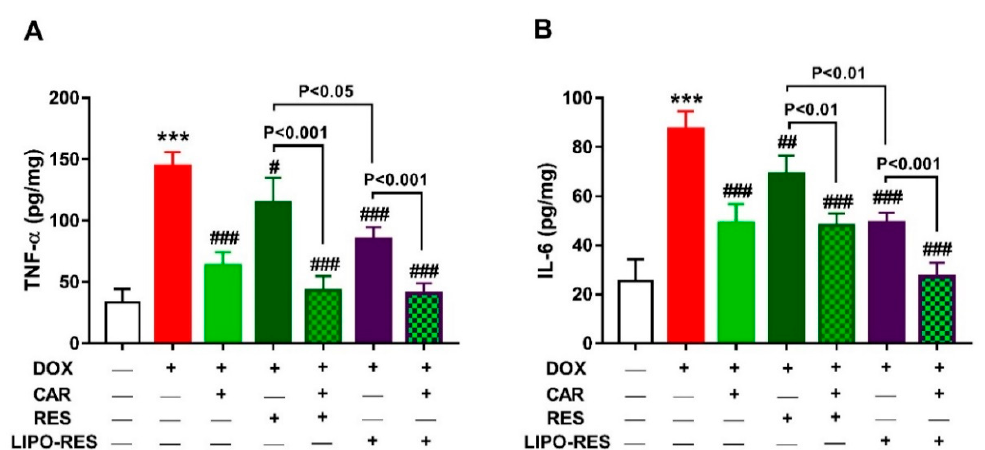
Figure 5. CAR and/or RES and LIPO-RES decrease cardiac TNF- α ( A ) and IL-6 ( B ) in DOX-intoxicated rats. Data are expressed as mean ± SEM, ( n = 6). *** p < 0.001 versus Control. # p < 0.05, ## p < 0.01 and ### p < 0.001 versus DOX.